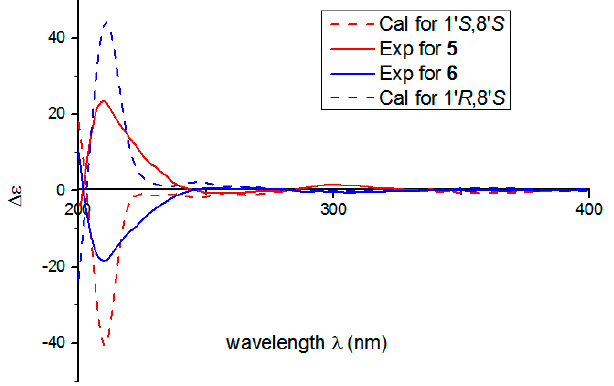
Figure 5. The calculated and the experimental ECD spectra of 5 and 6 . Table 3. 1 H- and 13 C-NMR data of 5 – 7 .